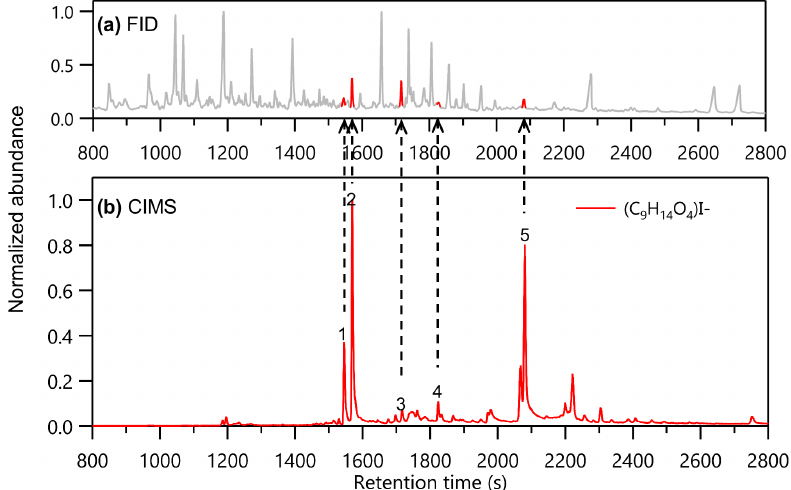
Figure 2. An example of isomers quantified in (b) the chromatogram of ion ( C 9 H 14 O 4 ) I − in CIMS with (a) their corresponding FID peaks (highlighted in red). The peaks marked with numbers are those included in the analysis of isomer sensitivity.